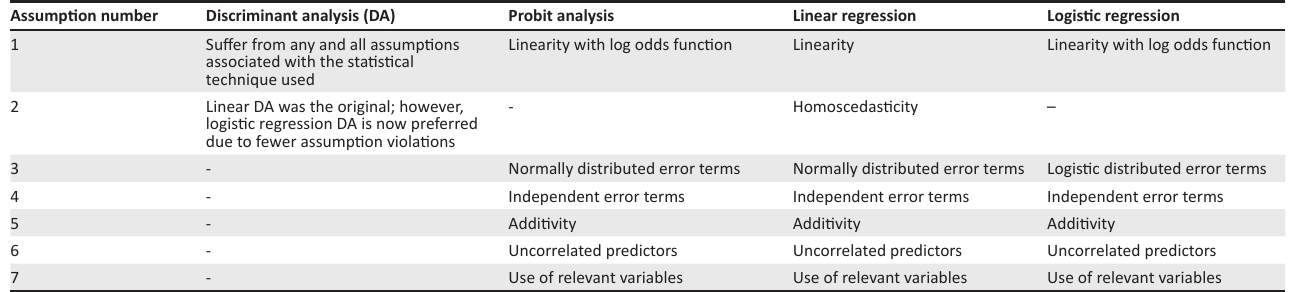
TABLE 2: Parametric techniques assumptions. Assumption